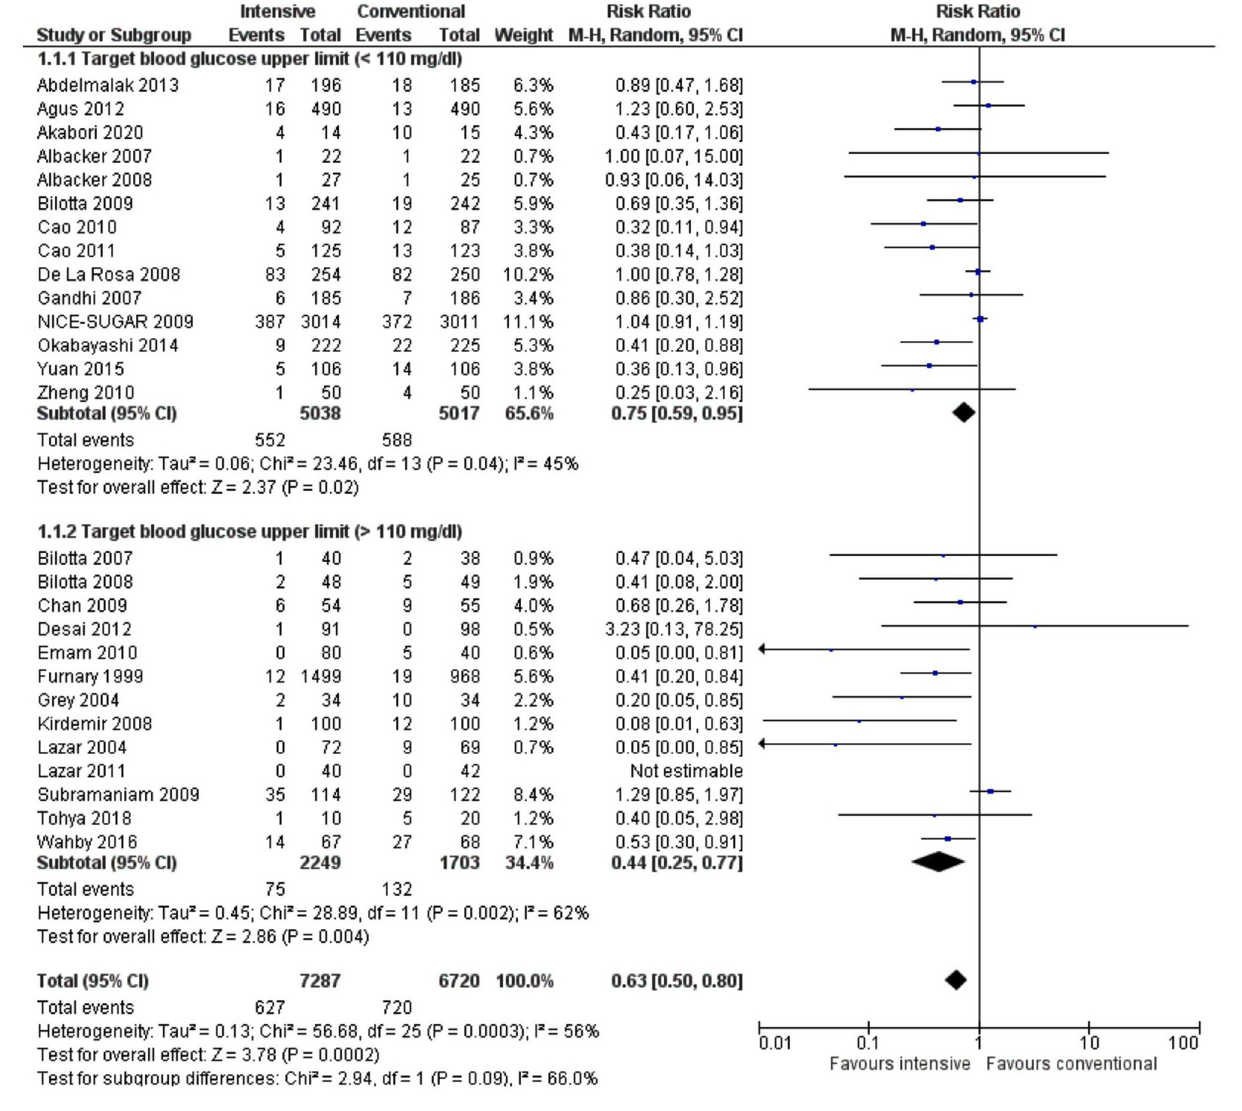
in measurement bias and increase in hypoglycemic